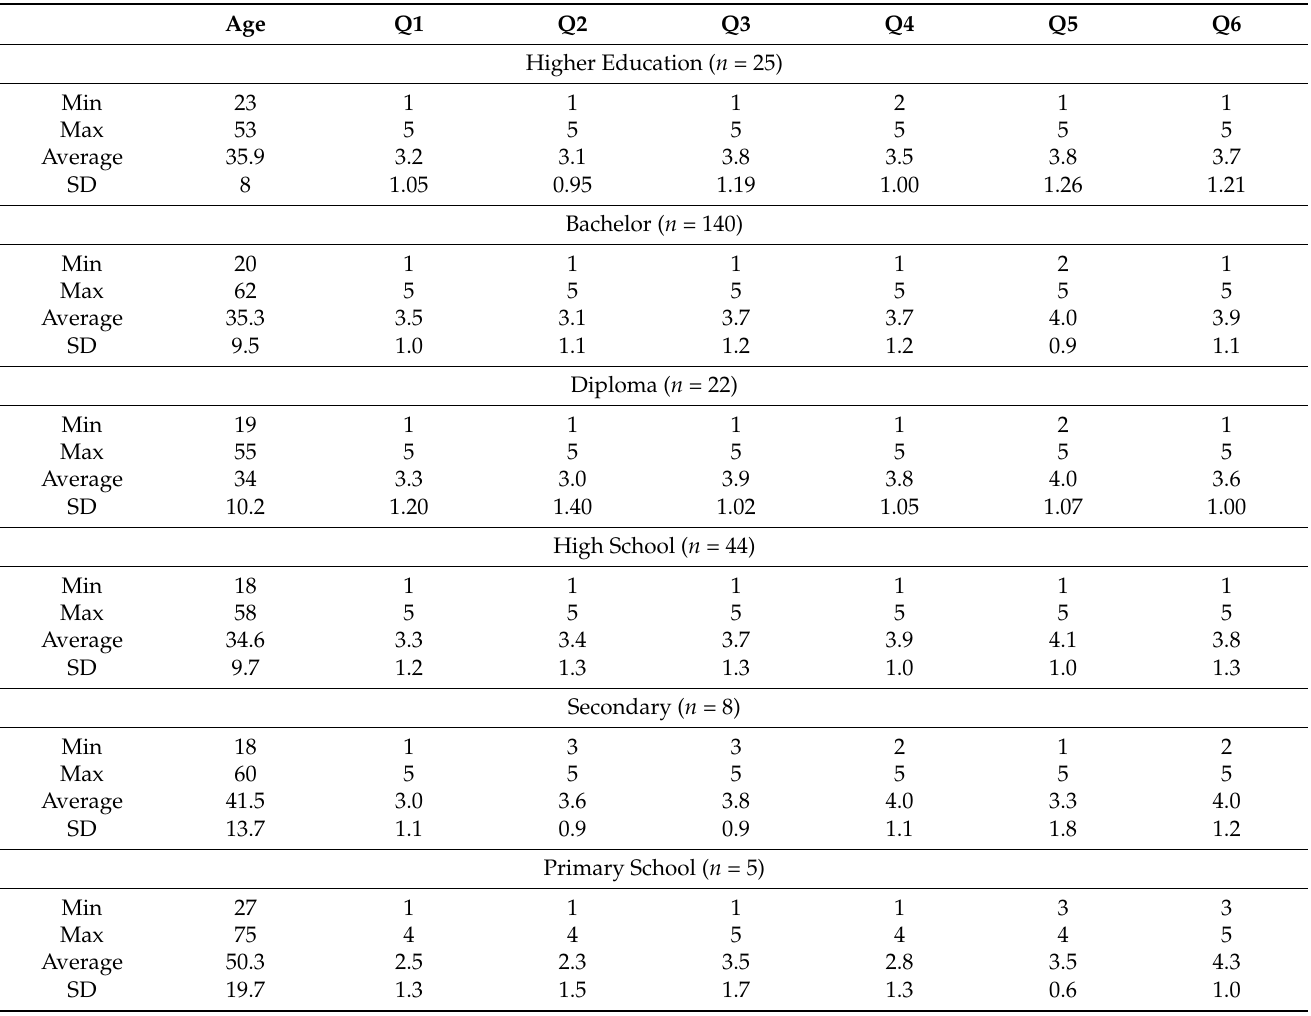
Table 4. Confidence level according to age and level of